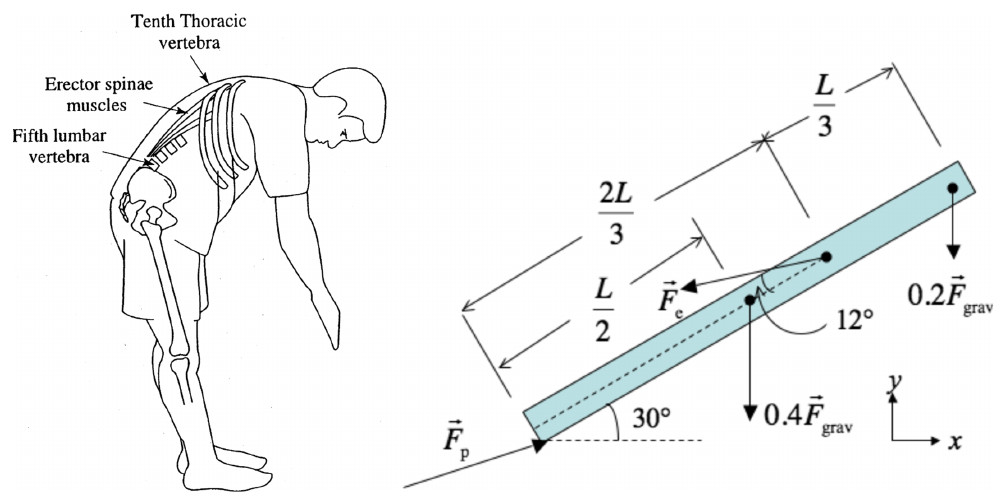
FIG. 5. Free-body diagram of the spinal column in a bend-forward